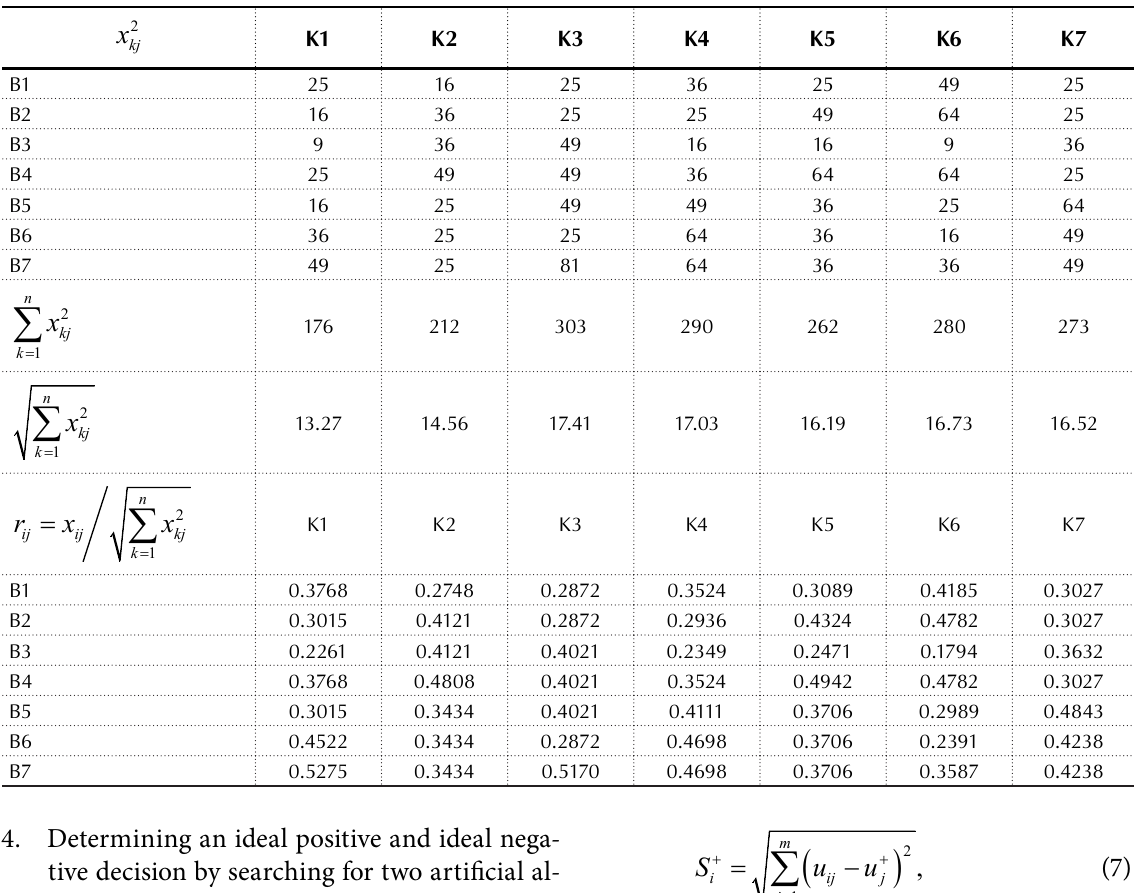
Table 7. Normalized decision matrix